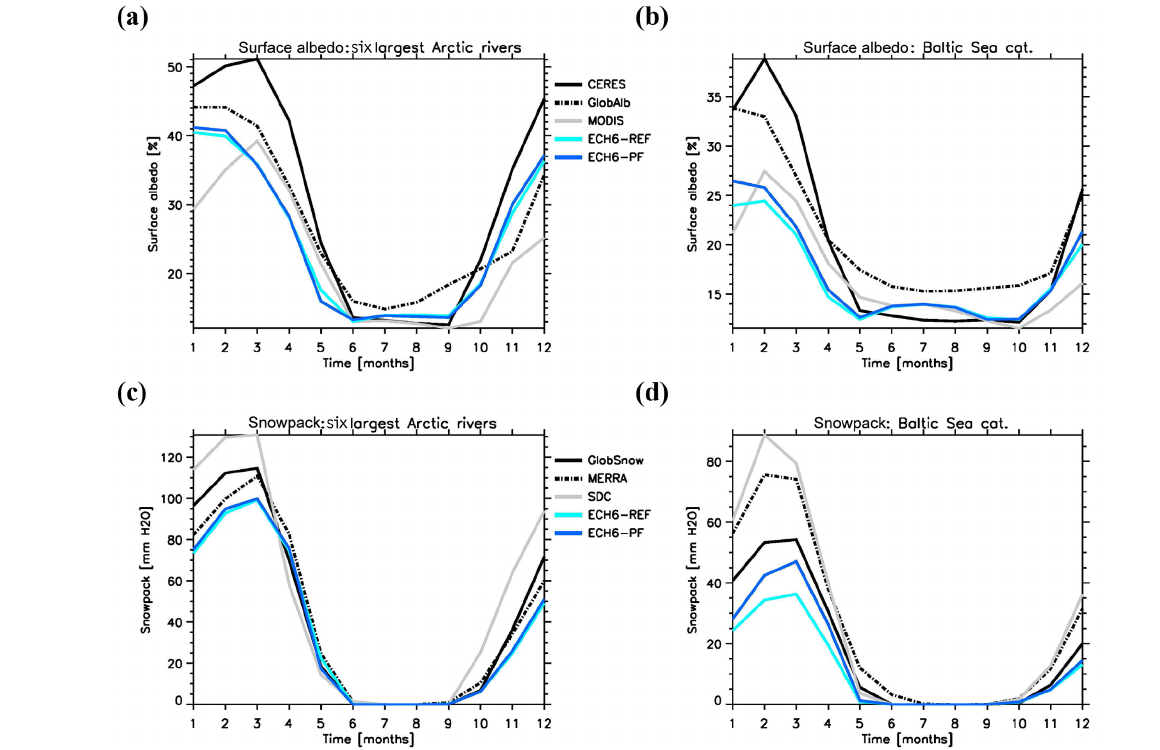
Figure 10. Mean monthly climatology (1989–2009) of surface albedo (upper panels) and snowpack snow water equivalent (SWE; lower panels) over the six largest Arctic river catchments (left column) and the Baltic Sea catchment (land only, right column). Albedo observations data from MODIS (2000–2011), CERES (2000–2010), and GlobAlbedo (1998–2011); SWE observations comprise data from GlobSnow